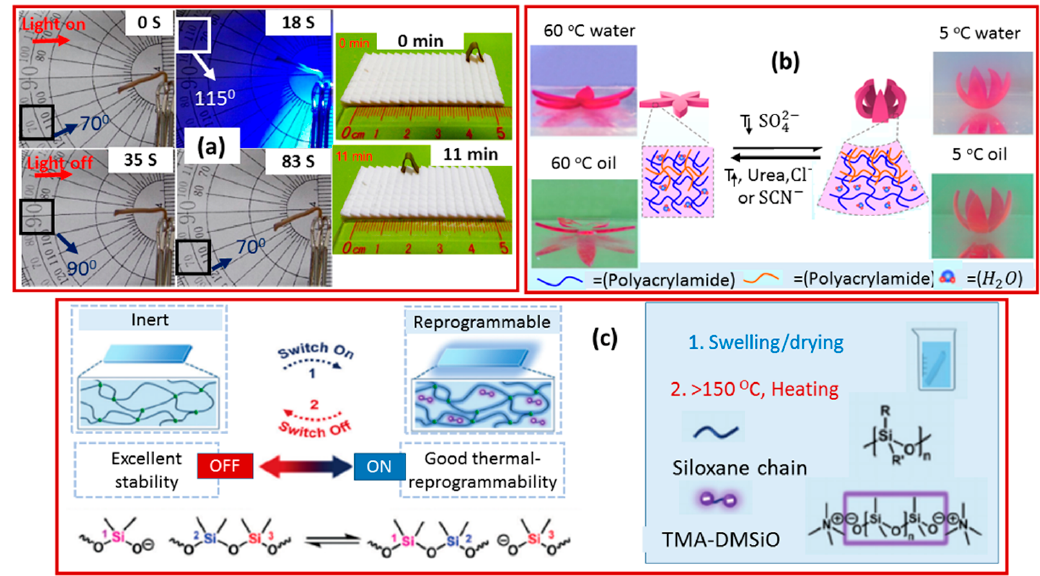
Figure 2. Various programmable shape-memory polymeric artificial muscles based on ( a ) PCL and polydopamine (Reprinted (adapted) with permission [40]. Copyright (2018) American Chemical Society); ( b ) hydrogel (Reprinted (adapted) with permission [68]. Copyright (2019) American Chemical Society); ( c ) liquid crystal elastomer (Reprinted (adapted) with permission [69]. Copyright 2020 John Wiley and Sons).